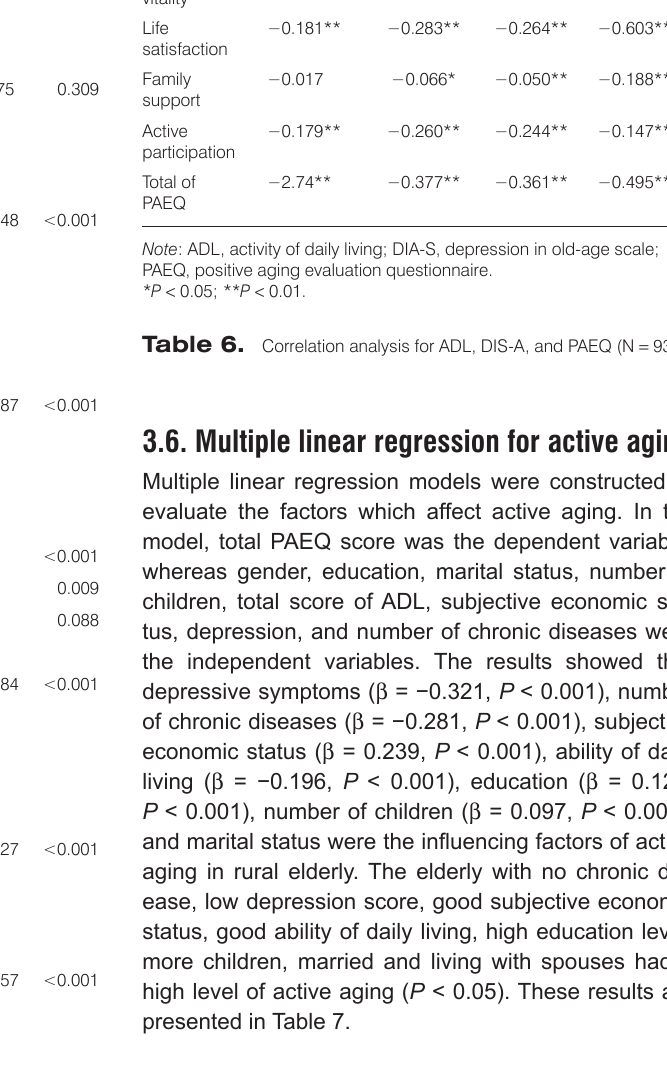
Table 5. Factors associated with active aging.